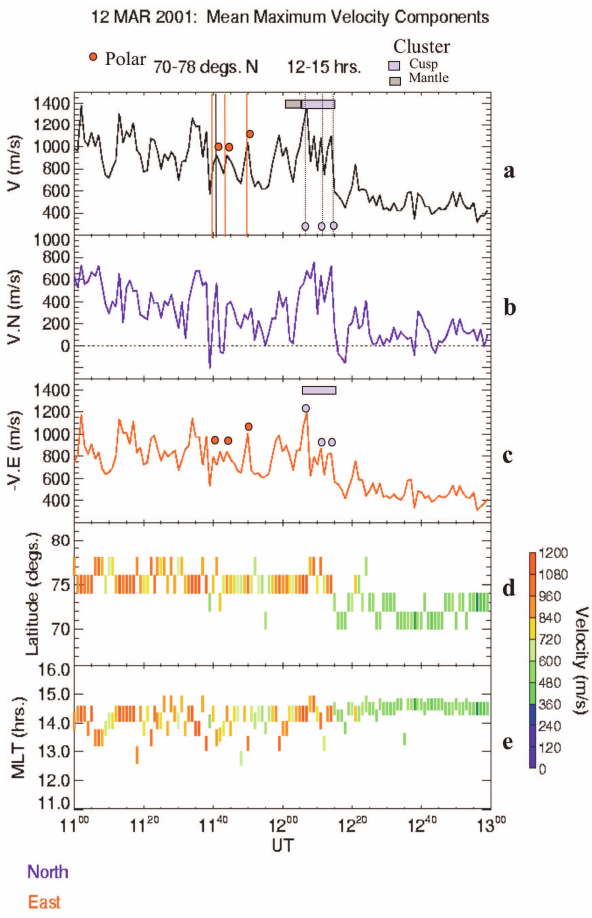
Fig. 5. Variations in the peak ionospheric flow velocity in the region 70–78Mlat between 12:00–15:00 MLT and 11:00–13:00 UT on 12 March 2001. This region contained the estimated footprints of Clus- ter and Polar. The black trace indicates the overall peak ionospheric velocity while the blue and red traces present the northward and westward components, respectively. The lower panels indicated the latitudinal and MLT location of the peak flow velocity, colour-coded according to the scale. (From Maynard et al.,